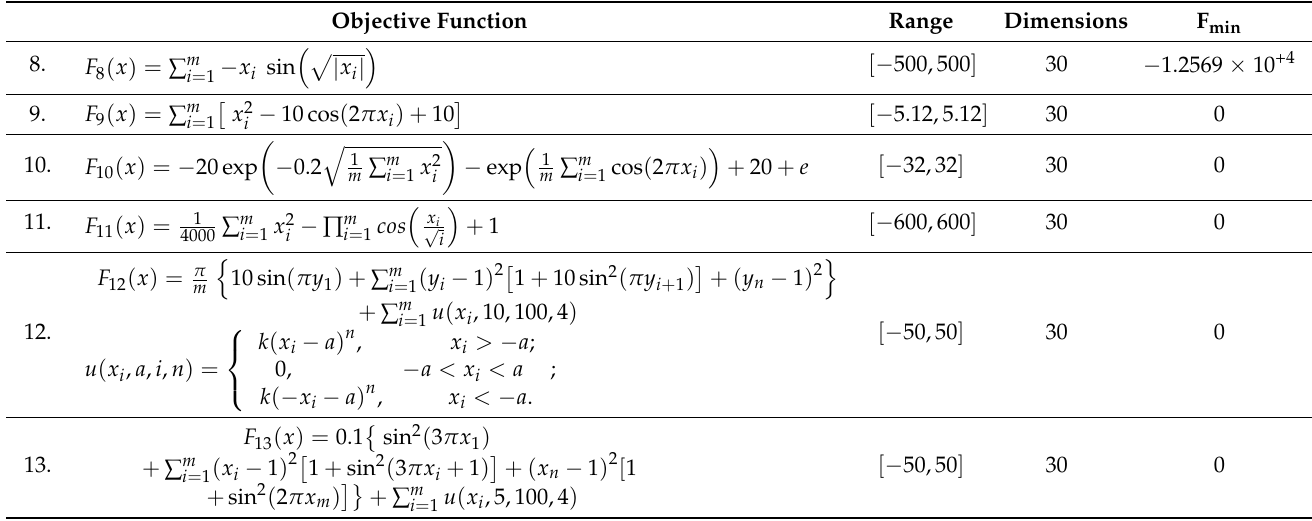
Table A2. High dimensional Multimodal test functions.